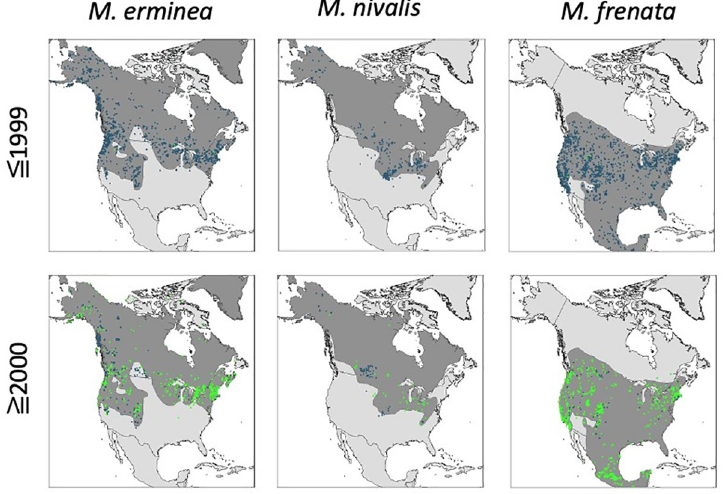
Fig 4. Distribution of records for three Mustela species from museum specimens (blue dots) and iNaturalist citizen science observation (green squares) from two time periods. Dark gray shading shows the range map for each